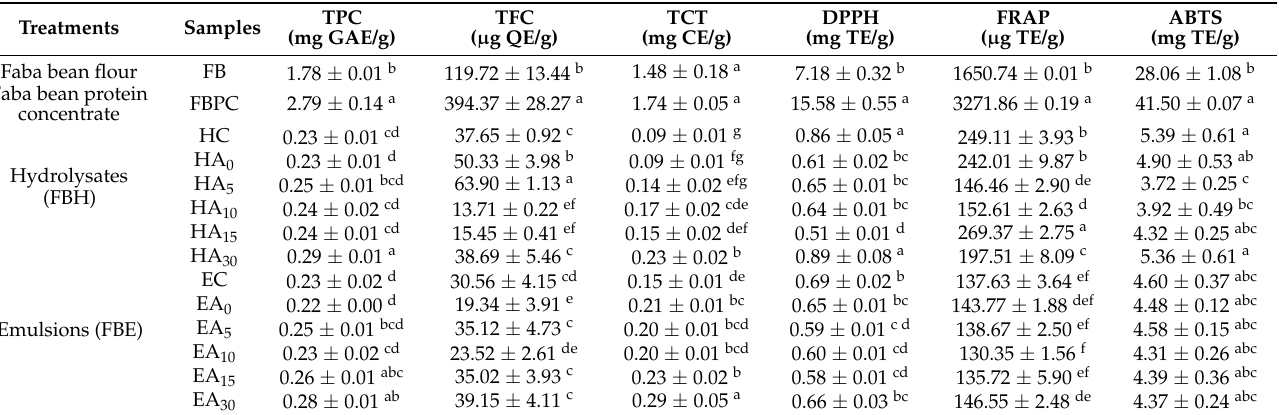
Table 1. The estimations of phenolic content and antioxidant capacities of faba bean (FB),